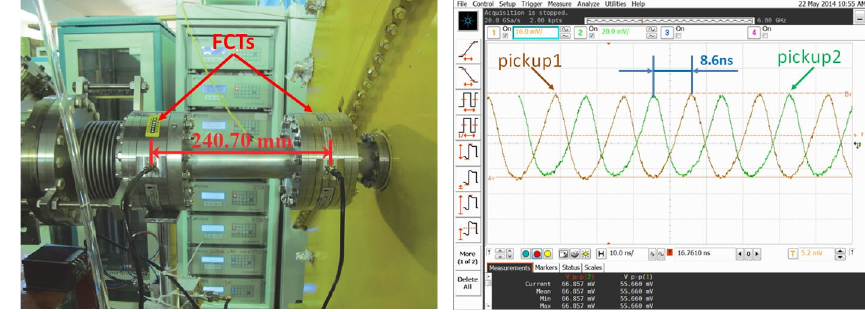
RFQ.FIG. 25. Beam signals detected by the two FCTs at the RFQ